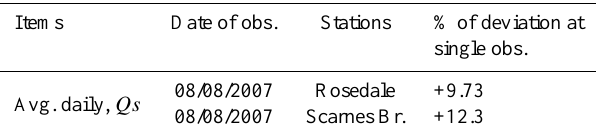
Table 8. Performance evaluation of suspended sediment modeling at Latrobe River